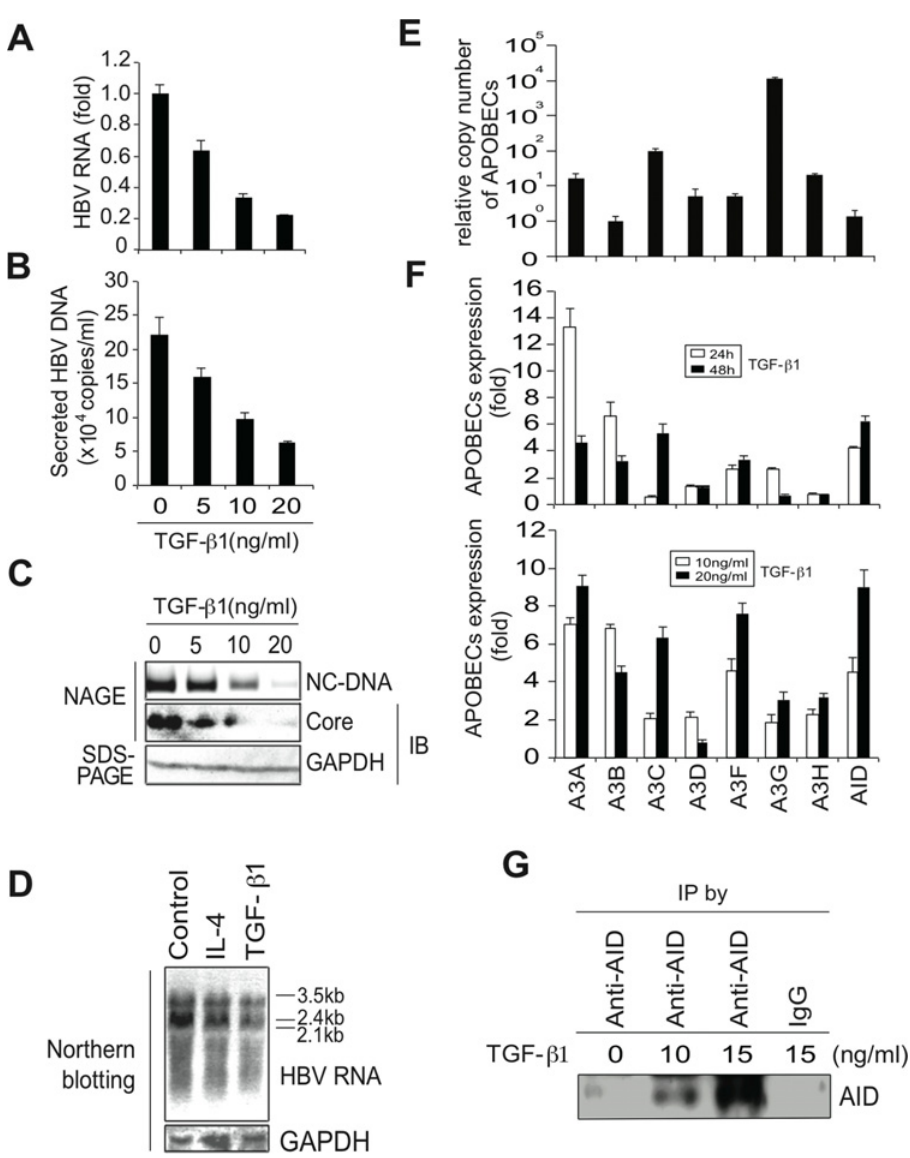
Fig 1. TGF- β 1 upregulates APOBEC3 expression and suppresses HBV replication in Huh7 cells. Six hours after transfection of pPB, Huh7 cells were treated with TGF- β 1 for 3 days, and HBV replication was evaluated. (A) qRT-PCR shows dose-dependent reduction of HBV transcripts by TGF- β 1. (B) NC-DNA levels in secreted virions were also measured using qPCR. (C) Nucleocapsid NC-DNA and core protein levels in crude cytoplasmic extracts were assessed using NAGE assays. GAPDH protein levels in the same crude extracts were determined using western blotting. (D) Huh7 cells were treated with 150 ng/mL IL-4 or 10 ng/ml TGF- β 1 for 3 days. Levels of HBV RNA and GAPDH mRNA were determined by Northern blot. Control: non- stimulated Huh7 cells. (E) Relative expression levels of APOBEC deaminases in non-stimulated Huh7 cells; Relative expression levels were determined using qPCR with cDNA from non-stimulated Huh7 cells and standard curves of control APOBEC deaminase DNA. Relative copy numbers of A3B were defined as one. (F) Induction of APOBEC deaminase expression in TGF- β 1-treated Huh7 cells was estimated using qRT-PCR. Fold induction of APOBEC deaminases is shown in the top (10 ng/mL TGF- β 1 for 24 or 48 h) and bottom (10 or 20 ng/mL TGF- β 1 for 24 h) panels. (G) Huh7 cells were treated with indicated concentrations of TGF- β 1 for 3 days. AID protein was immunoprecipitated using an anti-AID antibody (or an isotype control IgG, most right) and immunoprecipitated AID protein was determined by western blot. One lane contains immunoprecipitated protein harvested from 60% of 15 cm dish. All data are representative of two to four independent experiments. Error bars represent standard errors of the